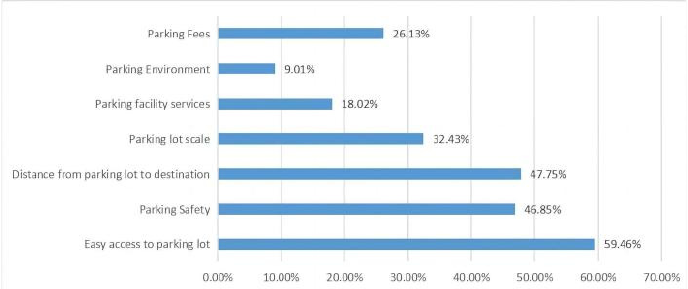
Figure 7. Considerations for choosing a parking facility.